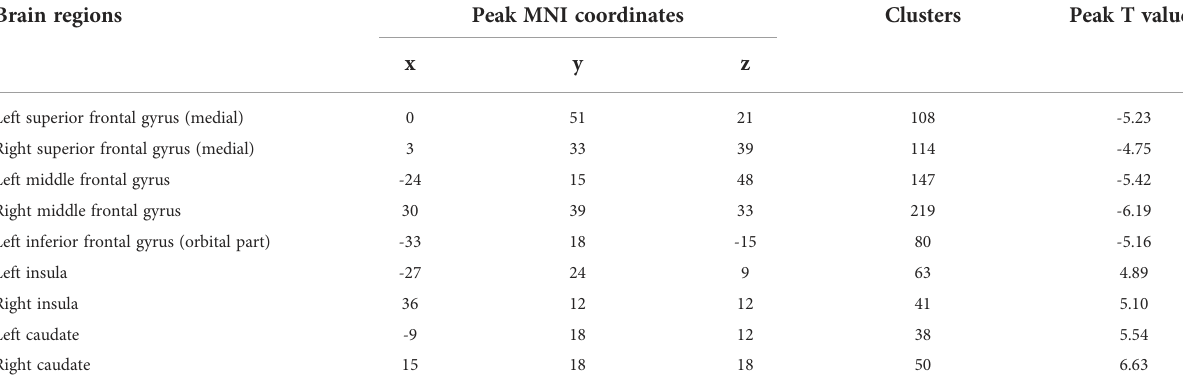
TABLE 2 Comparisons of ReHo values of brain regions in the AAL template between all NSCLC patients and HCs.